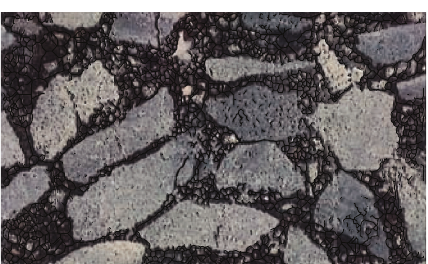
Figure 3: Composition